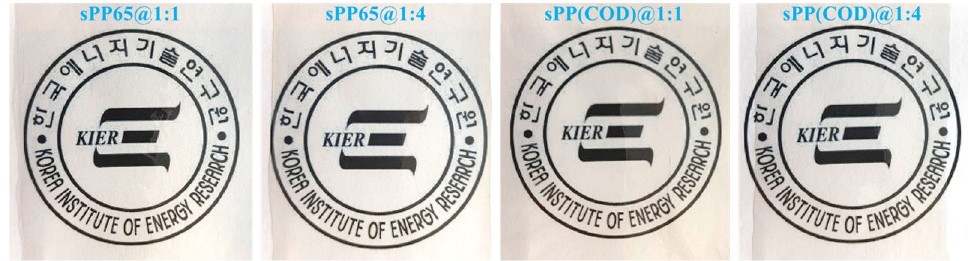
Figure 5. Digital photographs of sPP65 and sPP(COD) block copolymer membranes obtained from the polymerization of sPP65 block copolymers catalyzed using NiBr 2 (PPh 3 ) 2 and Ni(COD) 2 , respectively.